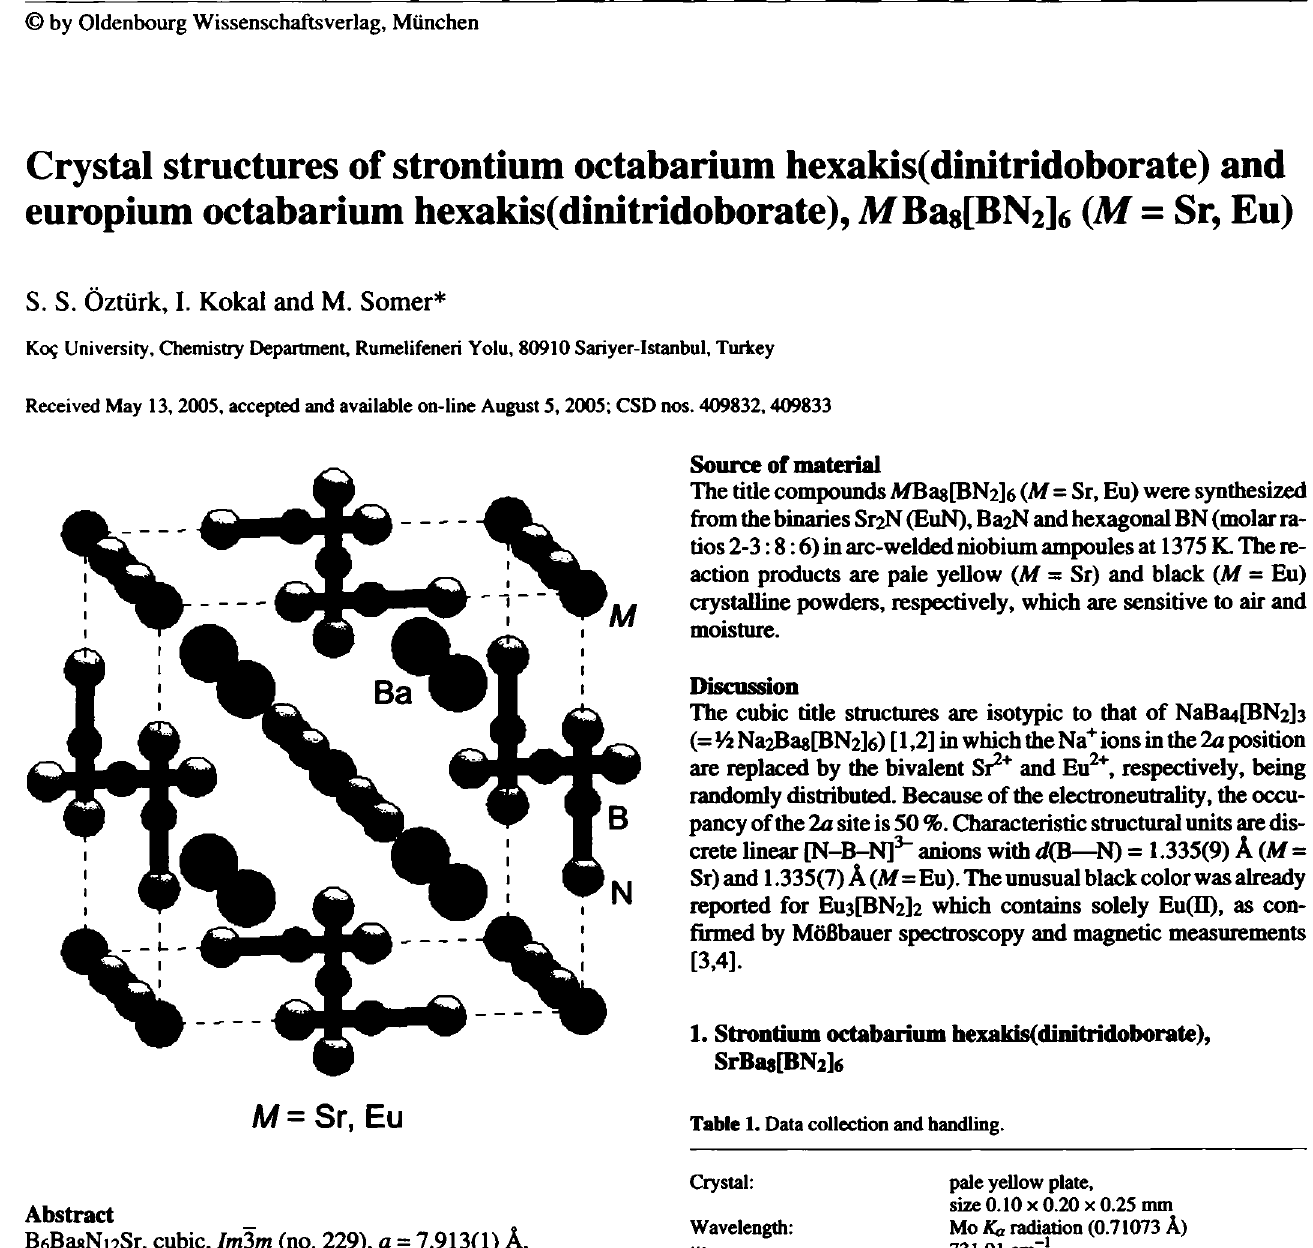
Table 1. Data collection and handling.